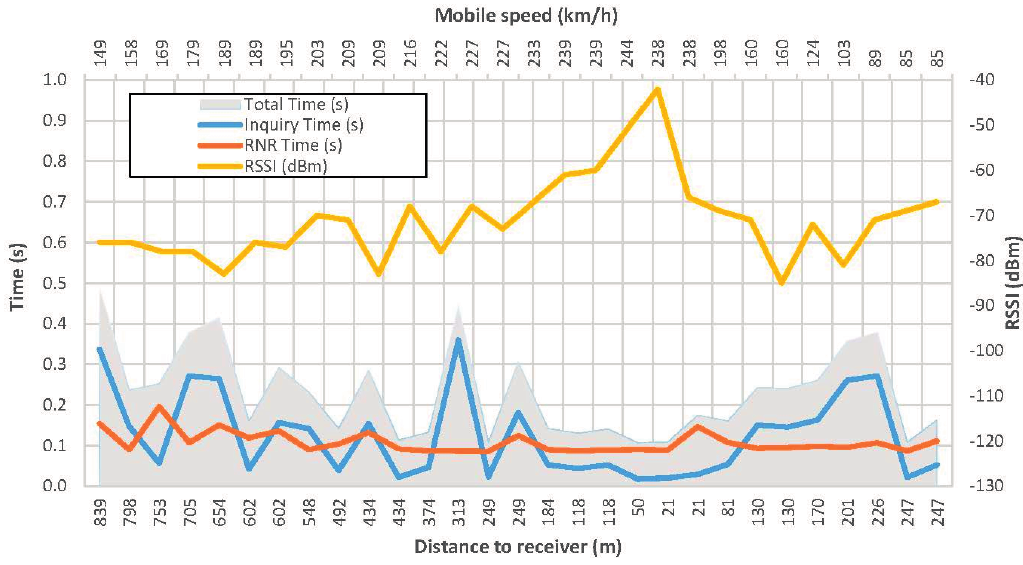
Figure 12. Results for a selected single pass.